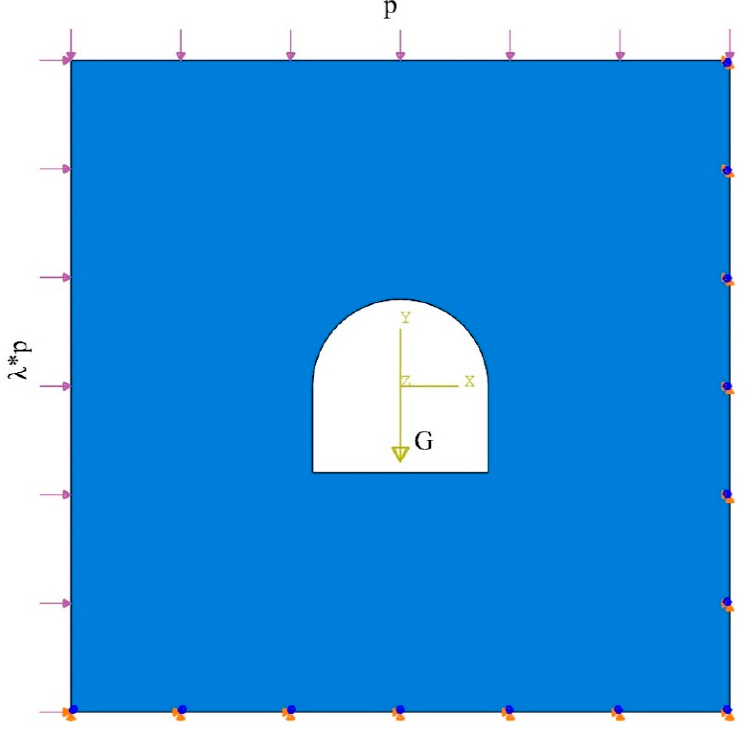
Figure 2. Tunnel boundary conditions.